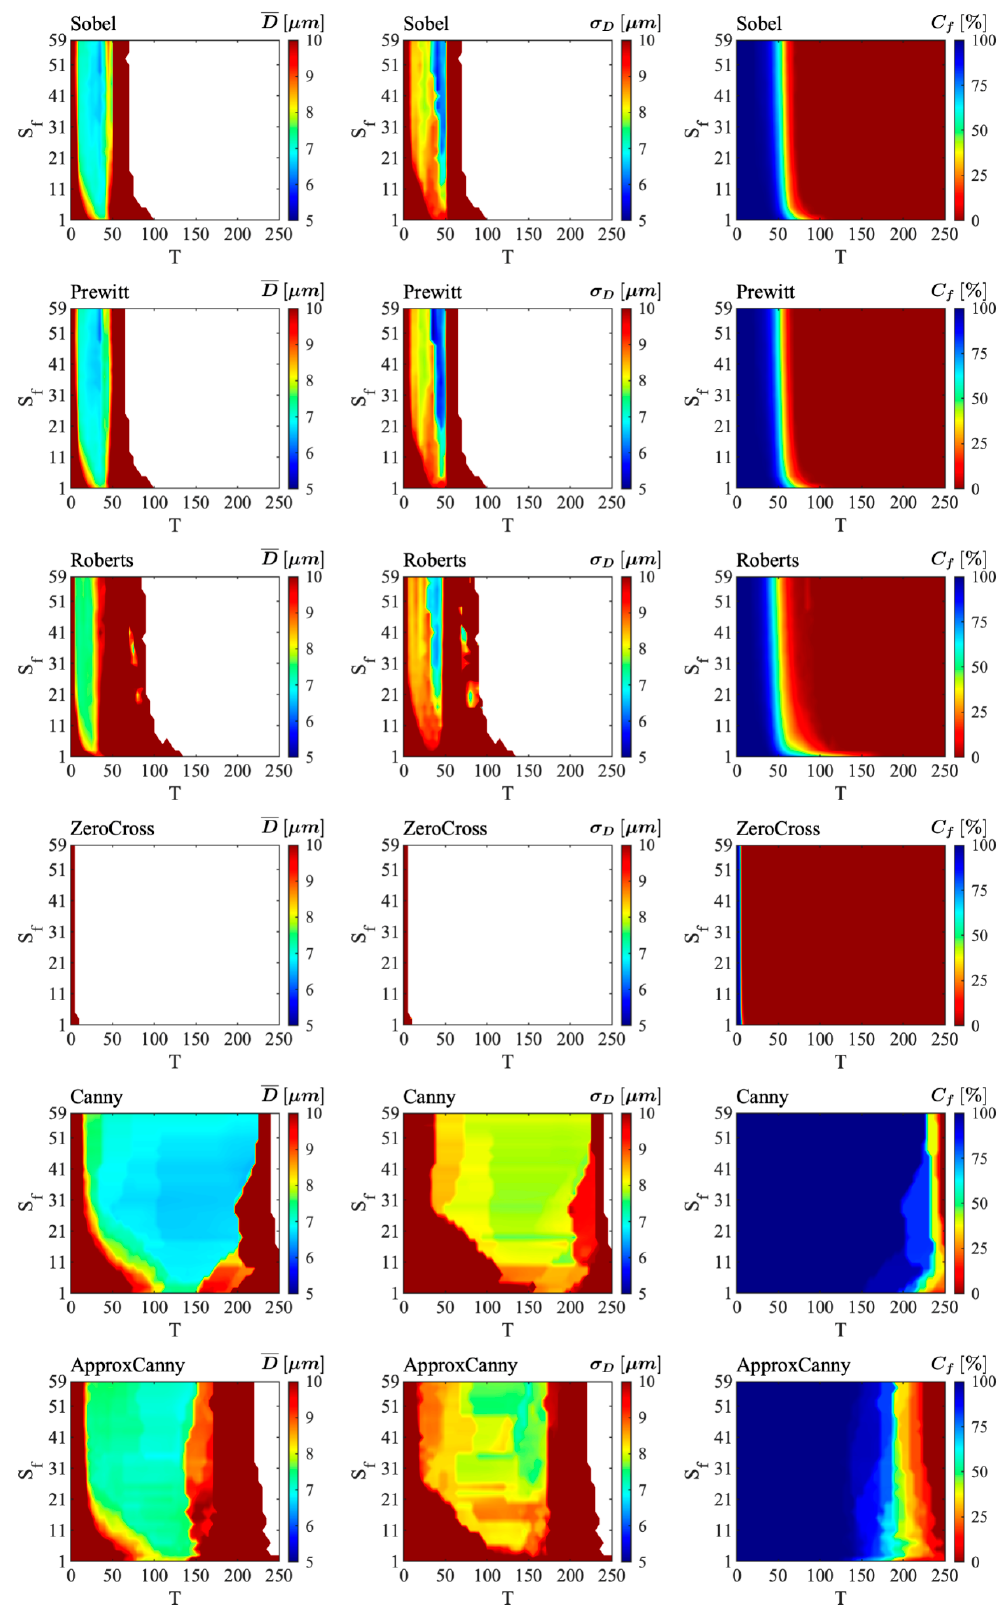
Figure 7. Measurement quality indicator (MQI) results as a function of 𝑆 (cid:3033) and 𝑇 for every 𝑀 calculated for 𝑆𝑂1 .